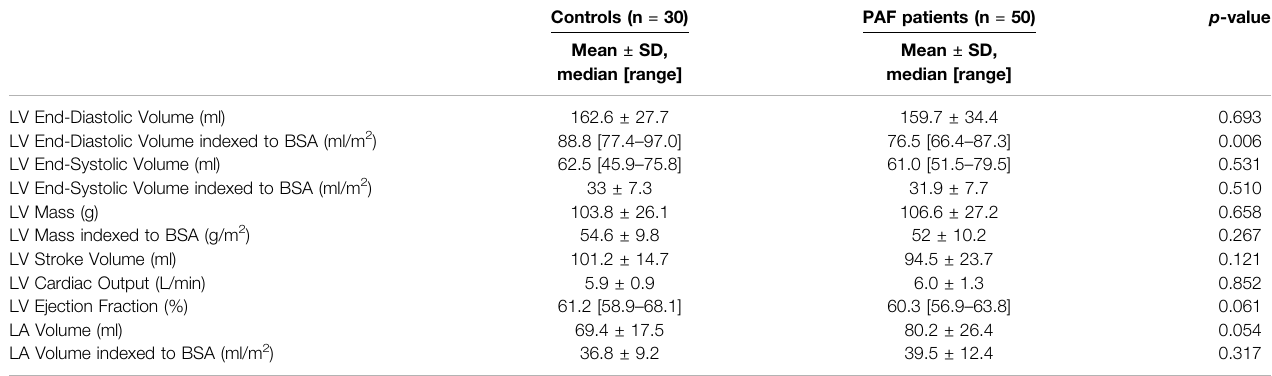
TABLE 3 | Left ventricular and atrial volumes and function.